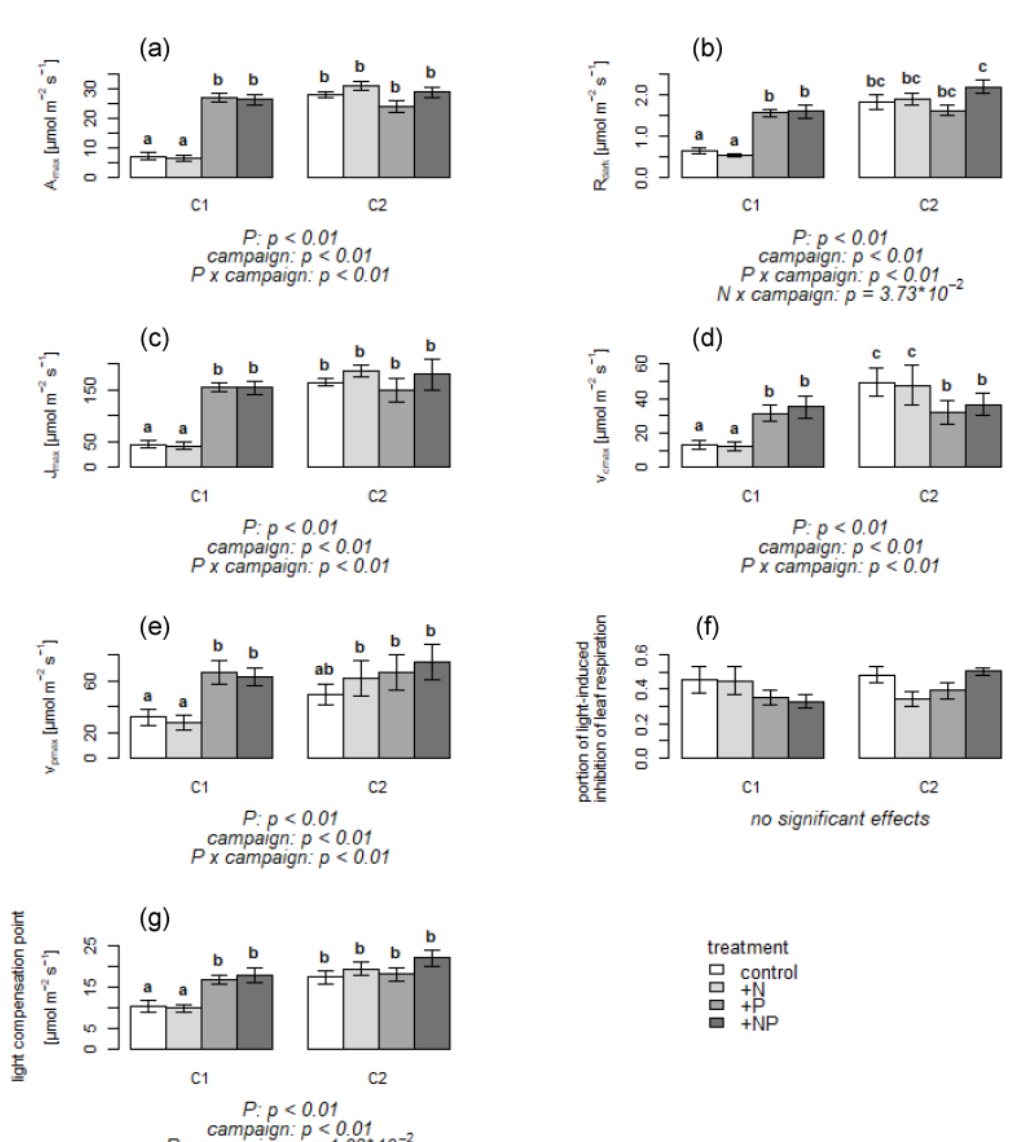
Figure 1. (a–g) Means of parameters deduced from leaf CO 2 exchange measurements per treatment and campaign. Error bars indicate stan- dard error. C1: campaign 1, end of June; C2: campaign 2, end of July; control treatment: not fertilized; + N treatment: nitrogen-fertilized; + P treatment: phosphorus-fertilized; + NP treatment: both nitrogen- and phosphorus-fertilized. Letters above bars indicate significant differ- ences. Significant effects are given with p value below the plots. A max : maximal assimilation rate; R dark : leaf dark respiration; R dark /A max : ratio of leaf dark respiration to maximal assimilation rate; J max : maximum electron transport rate; v cmax : maximal rubisco carboxylation rate; v pmax : maximum PEP carboxylation